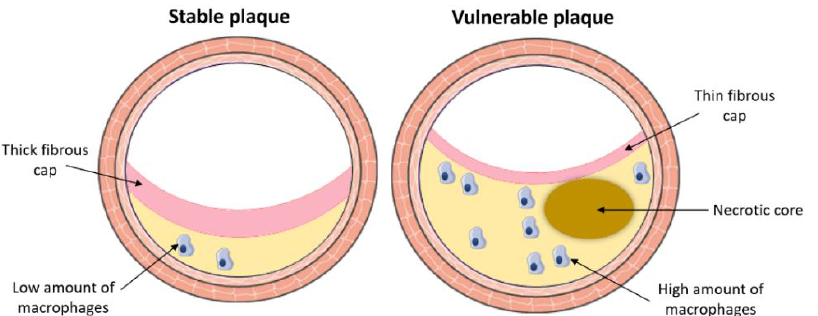
Figure 2. Atherosclerotic plaque vulnerability, an important factor for acute cardiovascular events, is due to lipid deposition, macrophage invasion and necrotic core formation. On the contrary, the fibrous cap, composed of smooth muscle cells and collagen, stabilizes the atherosclerotic plaque and protects it against rupture.